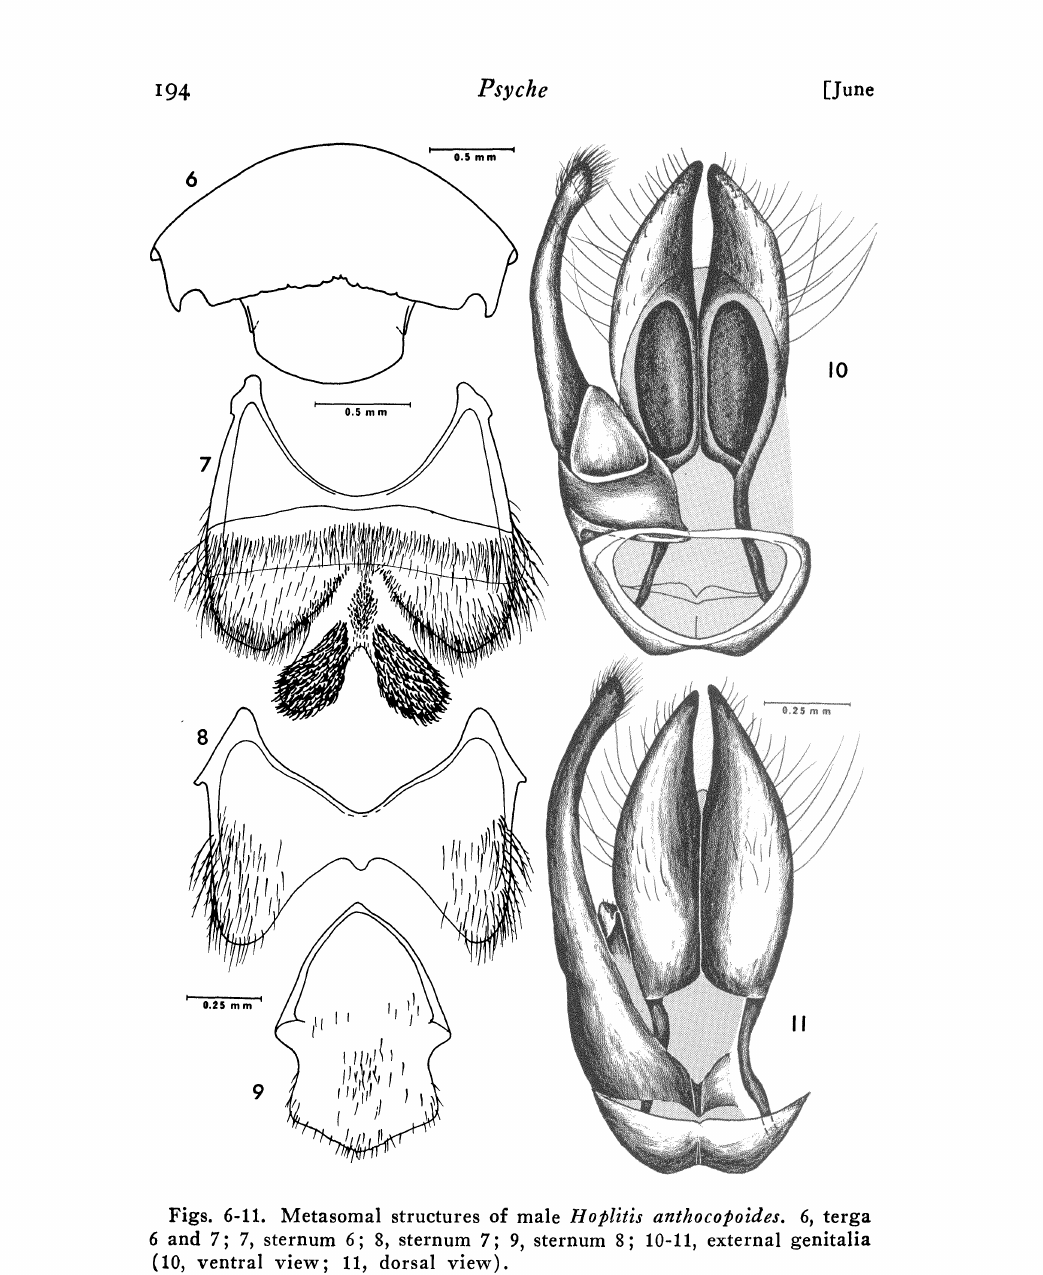
Figs. 6-11. Metasomal structures of male Hollitis anthocoloides. 6, terga 6 and 7; 7, sternum 6; 8, sternum 7; 9, sternum 8; 10-11, external genitalia (10, ventral view; 11, dorsal